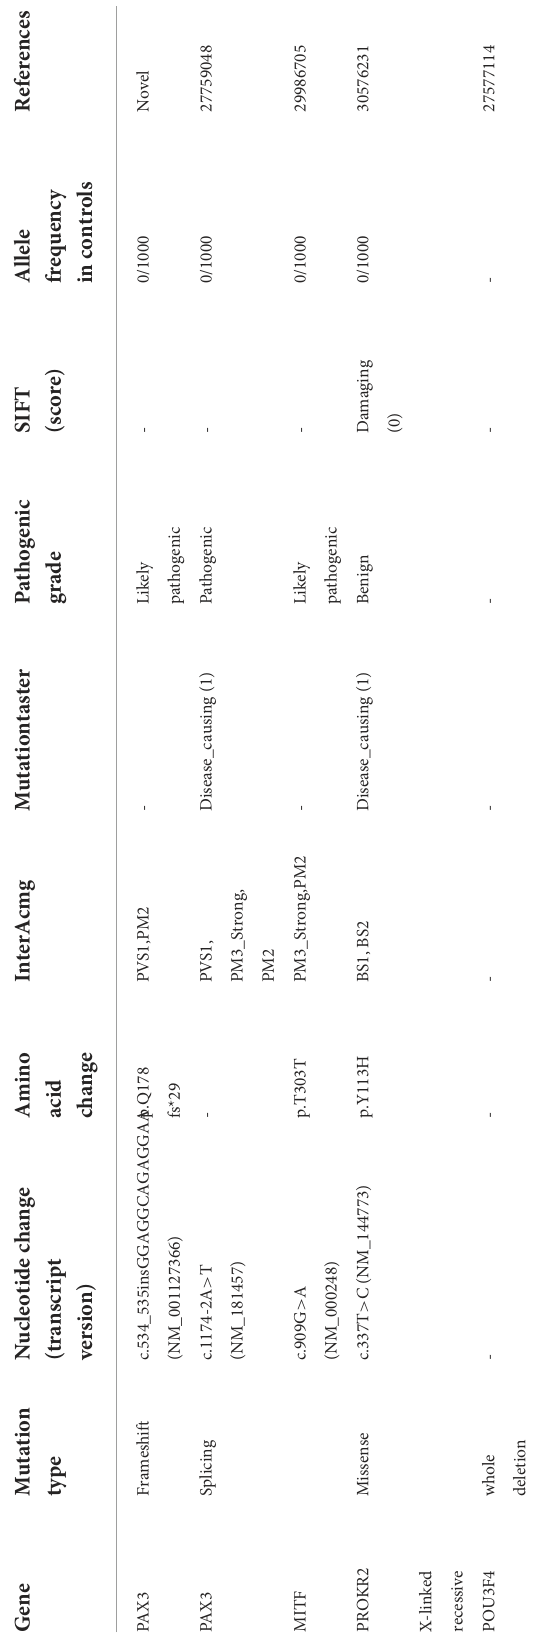
a duplication in ADGRV1 (OMIM 602851), partial or whole gene deletion in STRC (OMIM 606440), c.16 + 1C > T